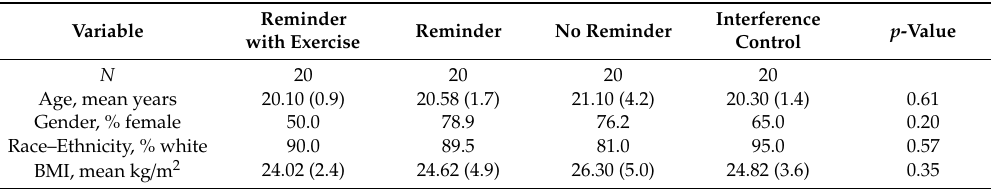
Table 3. Demographic characteristics of the